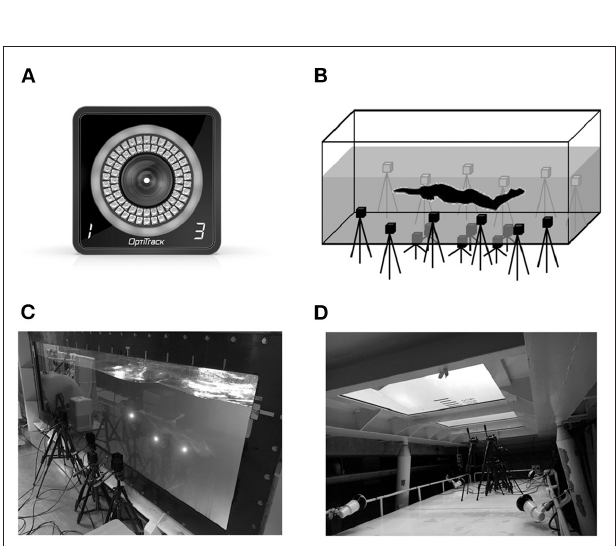
FIGURE 2 | Cameras and experimental settings. (A) A camera of the motion capture system. (B) The camera setting in the water flume. (C) The cameras at the side underwater window of the water flume. (D) The cameras at the bottom underwater window of the water flume.